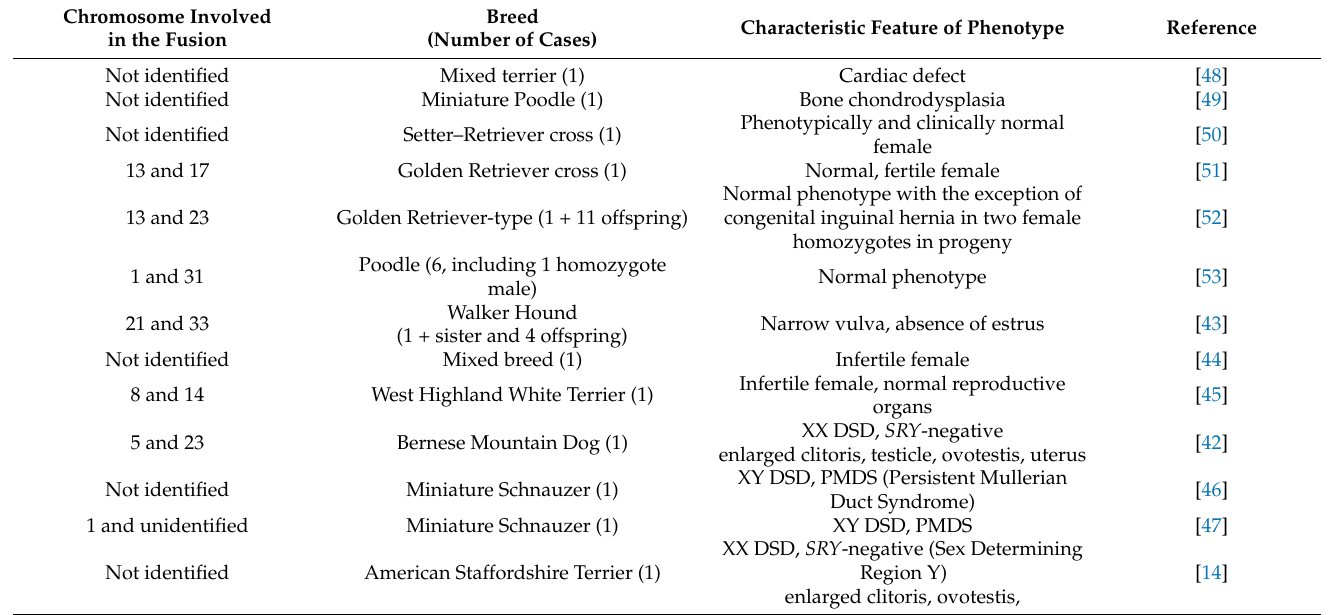
Table 5. Robertsonian translocations reported in